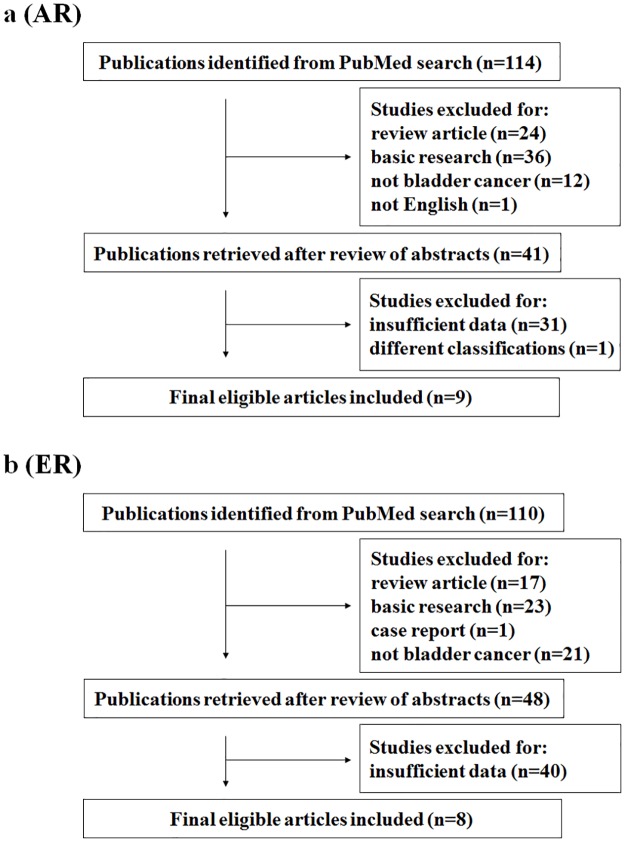
Flowchart of literature search and selection process.(a) AR and (b) ER.